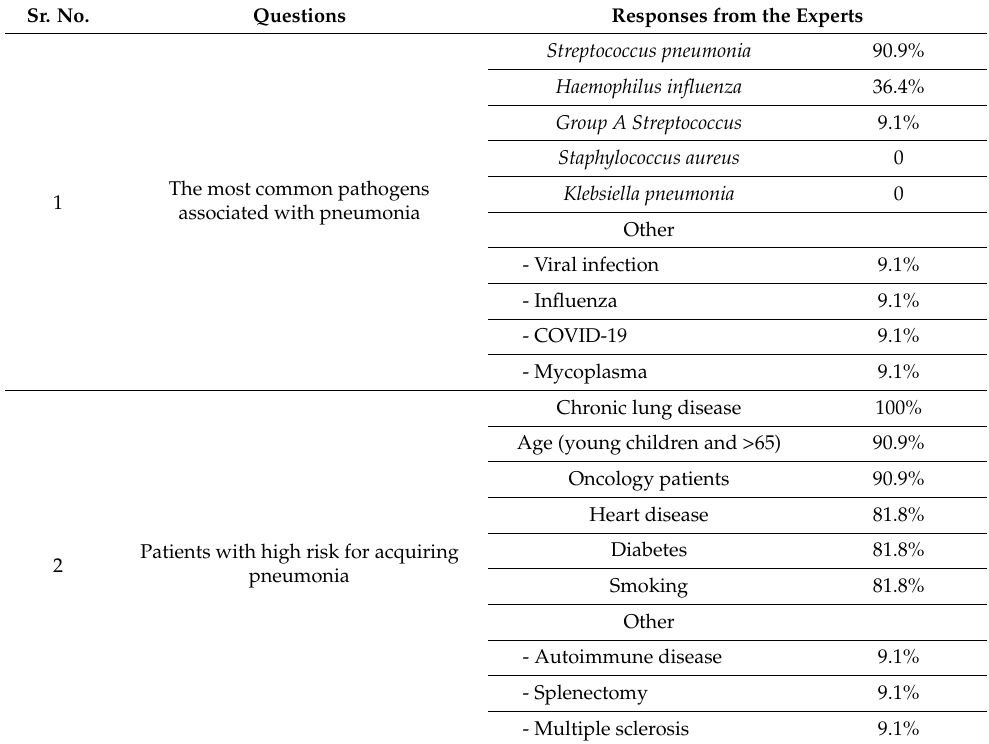
Table 1. Expert opinion on patient characteristics affected by pneumonia. Sr.